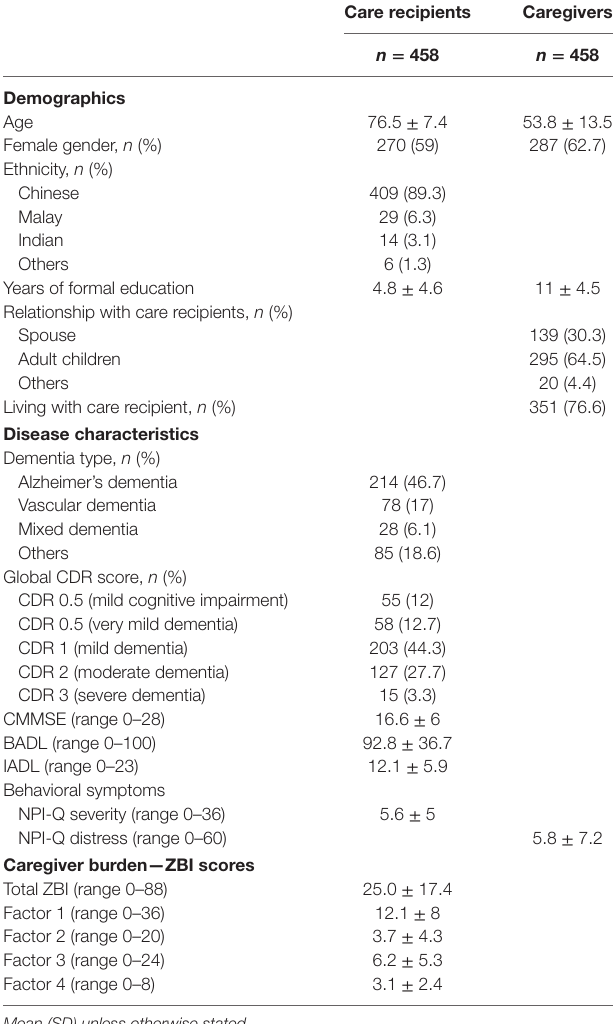
TaBle 1 | Characteristics of caregiver and care recipient